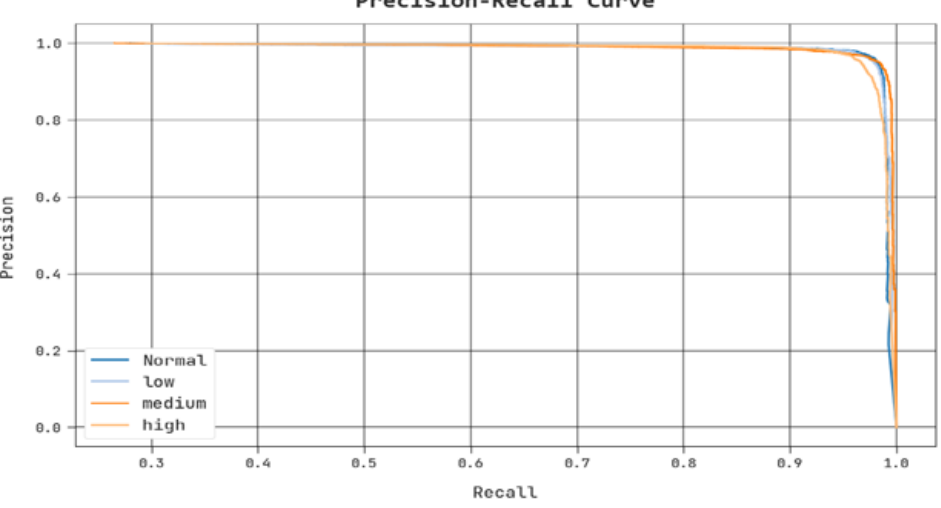
Figure 11. ROC analysis of the PPIE-ODLASC approach. In Table 6, a detailed comparison study of the PPIE-ODLASC with current DL techniques such as CNN with multilayer perceptron (MLP), CNN with multi-kernel extreme learning machine (MELM), CNN with extreme learning machine (CNN-ELM), CNN with optimal stacked extreme learning machine (CNN-OSELM), CNN with kernel extreme learning machine (CNN-KELM), CNN with radial basis function (CNN-RBF), and CNN with SVM (CNN-SVM) is provided [34]. Figure 12 represents the comparative accident severity classification results of the PPIE-ODLASC model with respect to 𝒑𝒑𝒑𝒑𝒑𝒑𝒂𝒂 𝒏𝒏 and 𝒑𝒑𝒑𝒑𝒂𝒂𝒂𝒂 𝒍𝒍 . The experimental results stated that the PPIE-ODLASC model has gained enhanced performance. Based on 𝒑𝒑𝒑𝒑𝒑𝒑𝒂𝒂 𝒏𝒏 , the PPIE-ODLASC model has gained increased 𝒑𝒑𝒑𝒑𝒑𝒑𝒂𝒂 𝒏𝒏 values of 96.68%, while the CNN-MLP, CNN-MELM, CNN-ELM, CNN-OSELM, CNN-KELM, CNN-RBF, and CNN-SVM models have reported reduced 𝒑𝒑𝒑𝒑𝒑𝒑𝒂𝒂 𝒏𝒏 values of 94.28%, 92.73%, 92.33%, 92.16%, 92.05%, 89.40%, and 88.66%, respectively. At the same